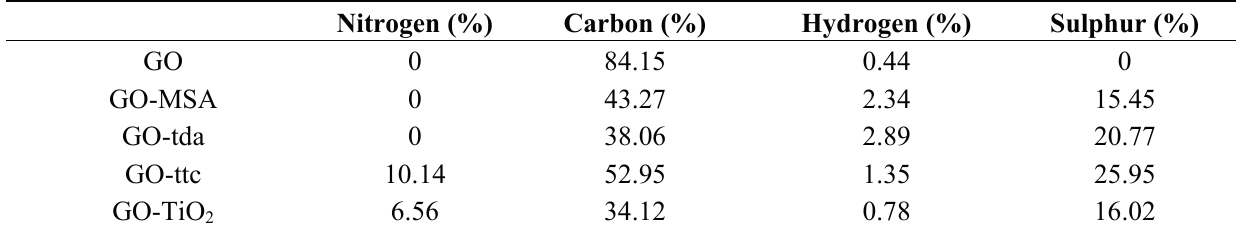
Table 2. Elemental analysis results of various modified graphene